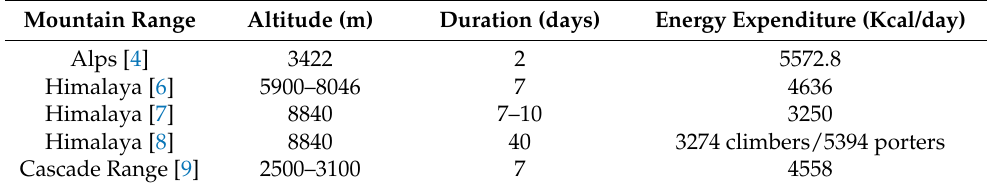
Table 1. The energy expenditure in